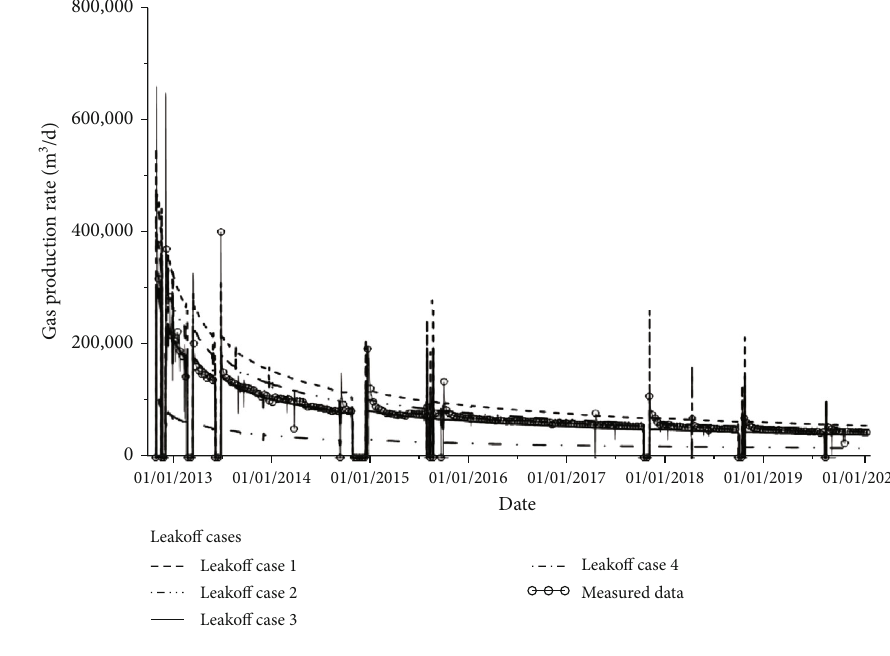
Figure 9: Reservoir simulation results of leako ff multiplier